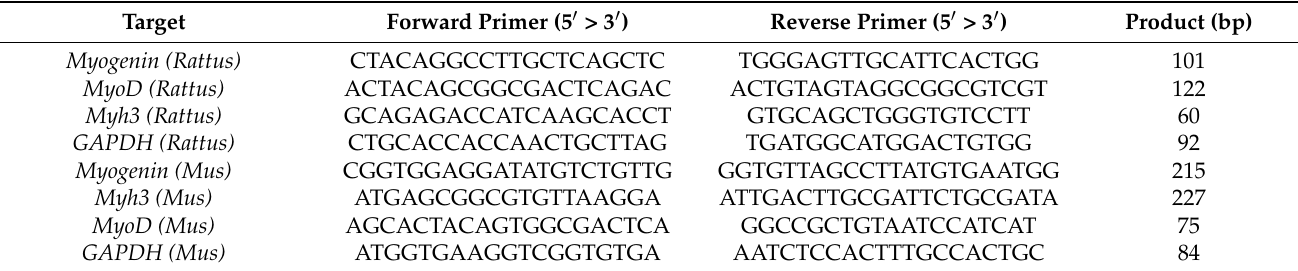
Table 1. Primer sequences and product